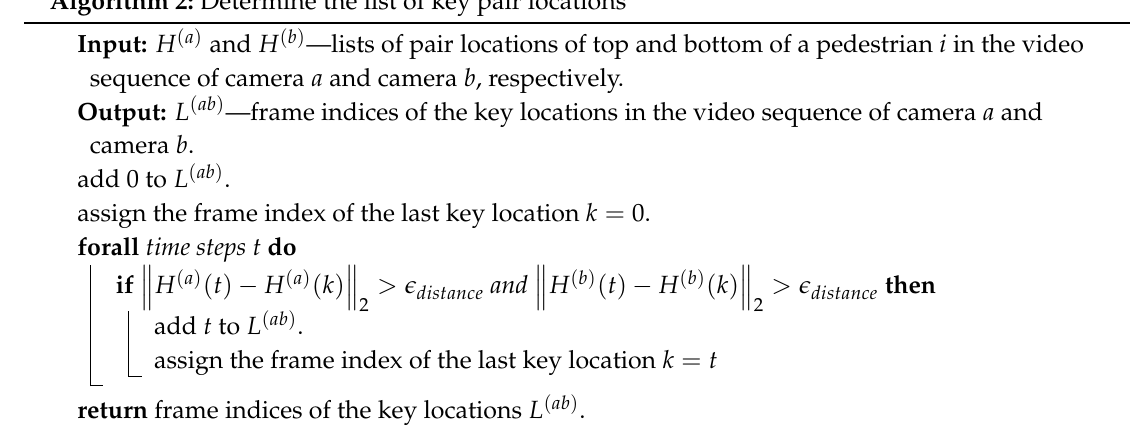
Algorithm 2: Determine the list of key pair